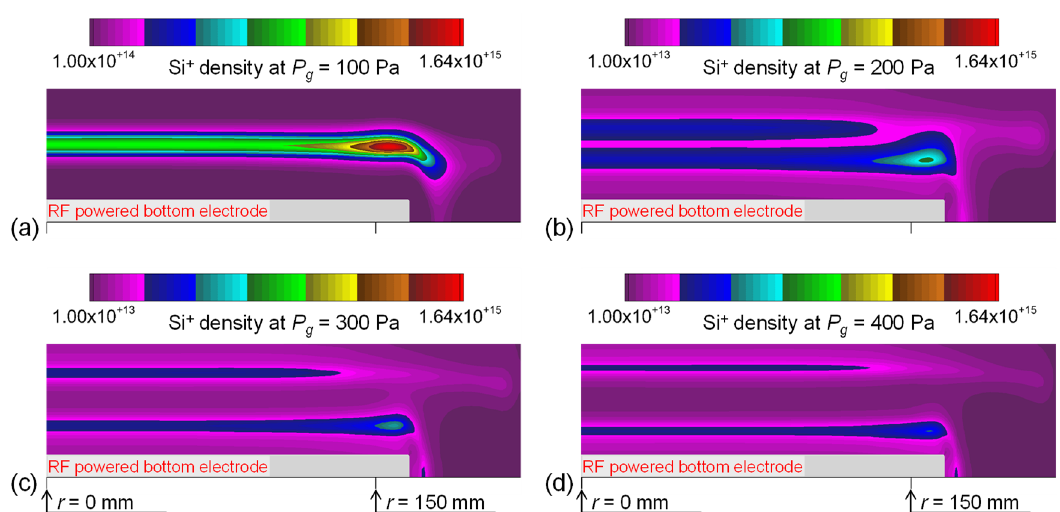
Figure 6. The spatial profiles of the time-averaged He* density (m − 3 ) ( a ) for Case 9, ( b ) for Case 10, ( c ) for Case 11, and ( d ) for Case 12.